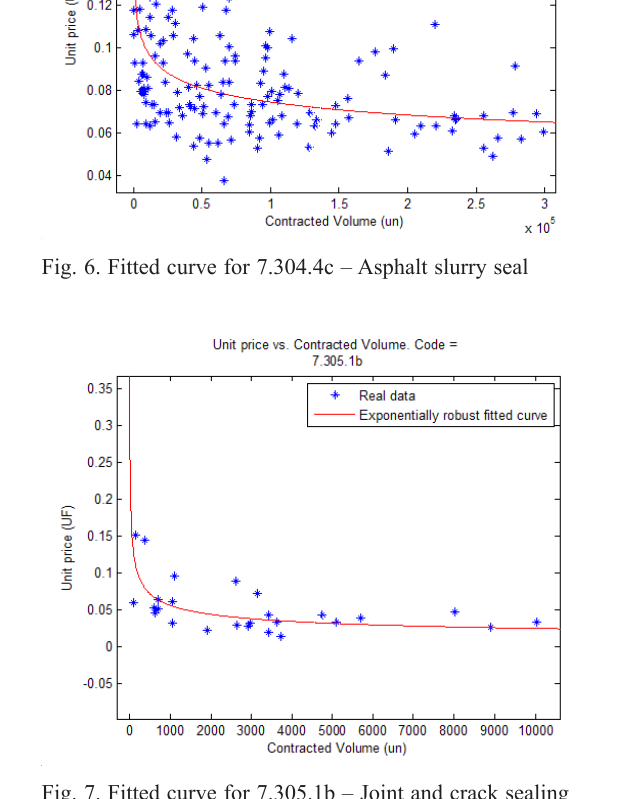
Fig. 7. Fitted curve for 7.305.1b – Joint and crack sealing